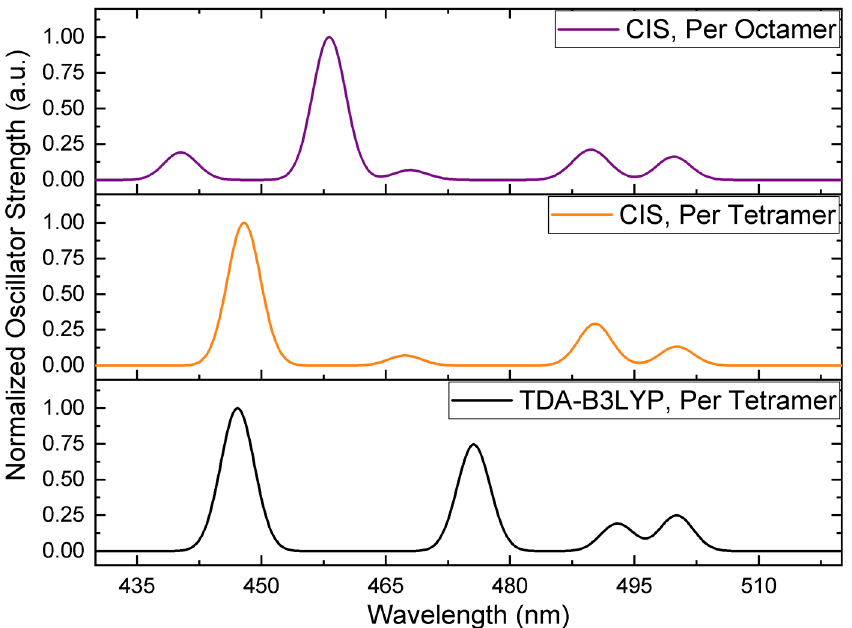
Figure 4. Simulated spectra for Per tetramers at the time dependent density functional theory (TD-DFT) (black) and configuration interaction with singles (CIS) (orange) levels of theory, and an octamer of Pers treated with CIS (purple), within the aqueously solvated PCP complex. All CIS wavelengths were systematically shifted by 0.671 eV to align the longest wavelength absorption with the corresponding TD-DFT band in order to aid a comparison. Gaussians with a full width at half maximum of 4 nm were fit to the calculated excitation wavelengths.